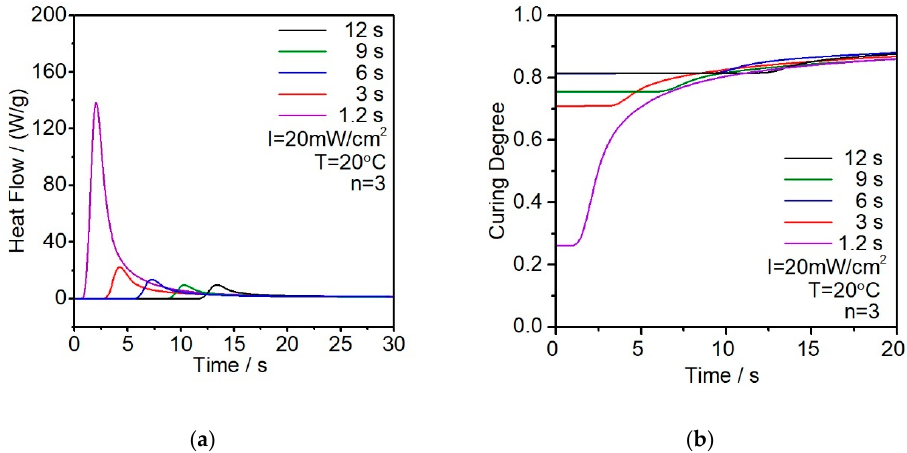
Figure 7. Thermal analysis during the second curing stage ( a ) Enthalpy analysis with different exposure times; ( b ) calculated curing degree in function with the exposure time.